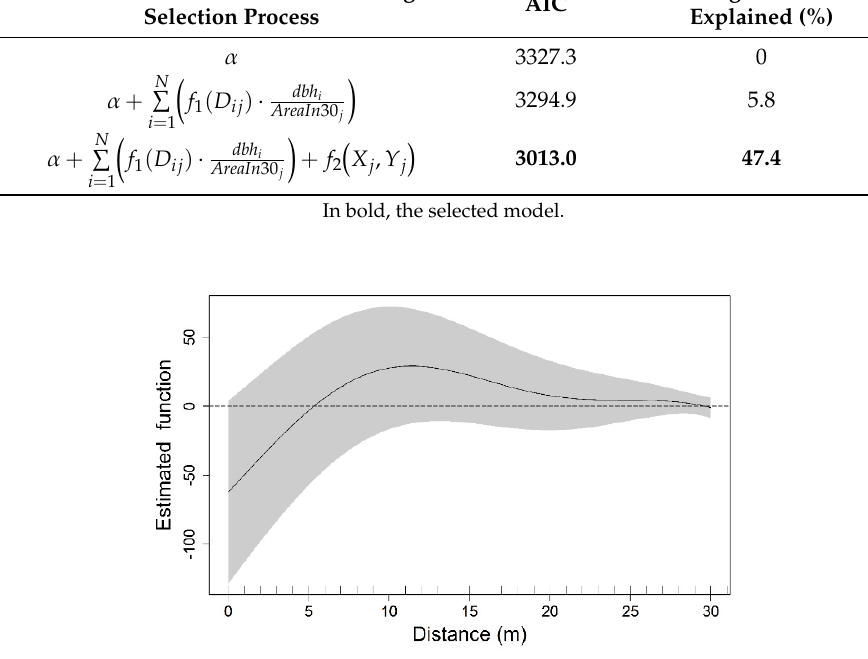
Figure 7. Estimated smooth coefficient function (continuous lines) of the diameter at breast height of adult trees over the distance between adult trees (stems with dbh ≥ 10 cm) and saplings (stems with height ≥ 1.30 m and dbh < 10 cm) and 95% confidence intervals (shaded area). Negative values of the function indicate the negative influence of the diameter at breast height of adult trees on the number of saplings.